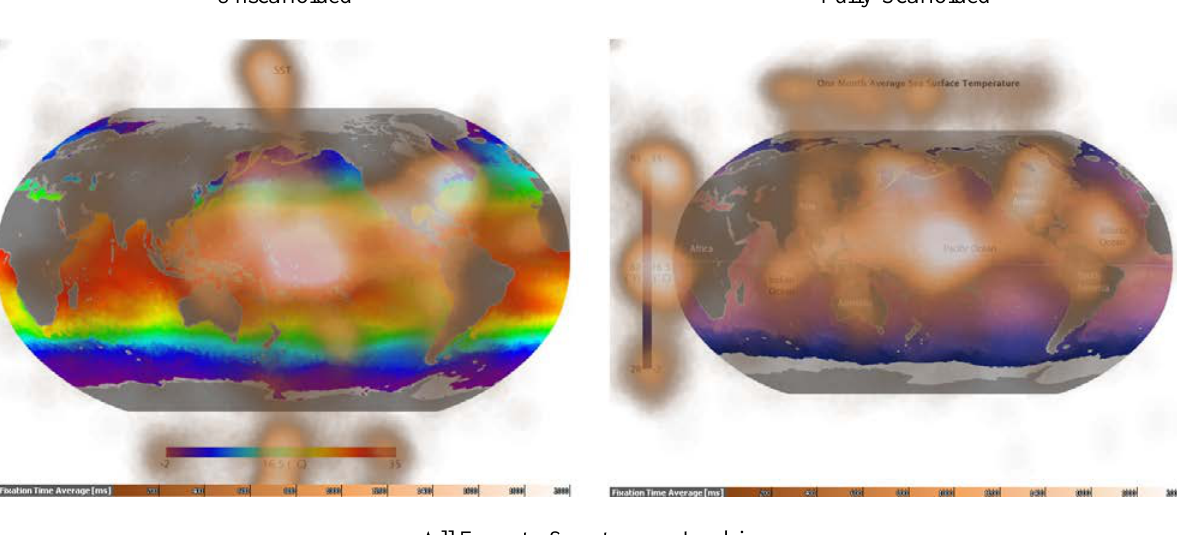
Appendix Figure 2. Heat maps showing all Novice (top left) and all Expert (bottom left) fixations in the first 10 seconds of viewing on unscaffolded visualizations (Spontaneous Looking). On right, novice (top) and expert (bottom) heat maps for scaffolded visualizations,